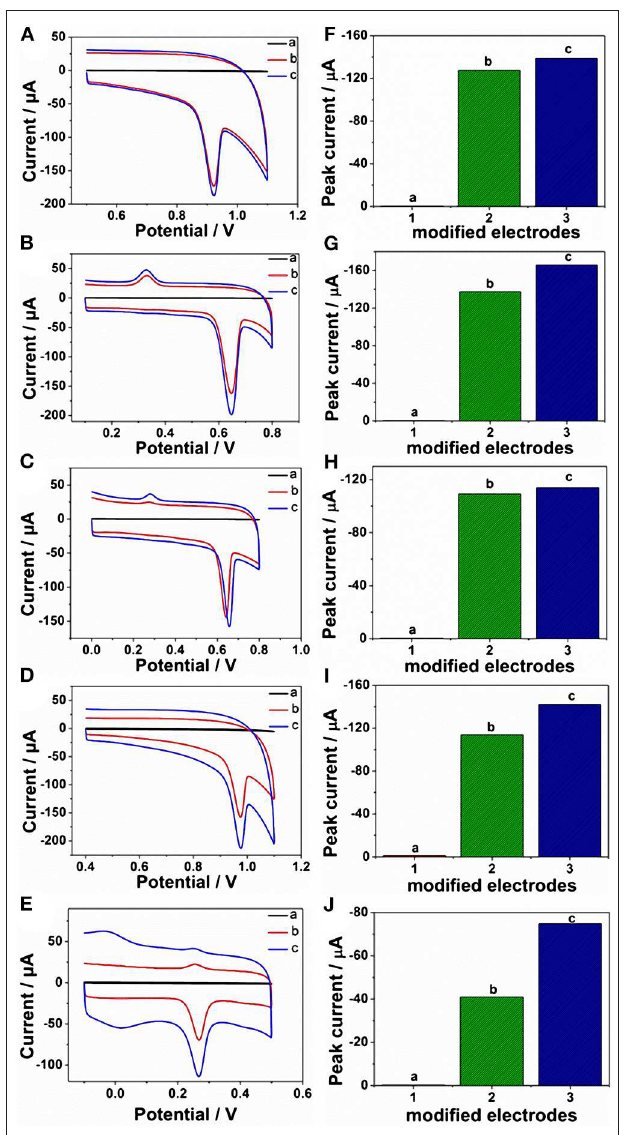
FIGURE 5 | CVs and peak current of CVs of (A,F) 5 µ M A, (B,G) 5 µ M G, (C,H) 5 µ M X, (D,I) 5 µ M HX, and (E,J) 5 µ M UA in 0.2M PBS (pH 6.8) on (a) bare GCE, (b) ErGO/GCE, and (c) ErGO-CP6/GCE. Scan rate: 50 mV · s − 1